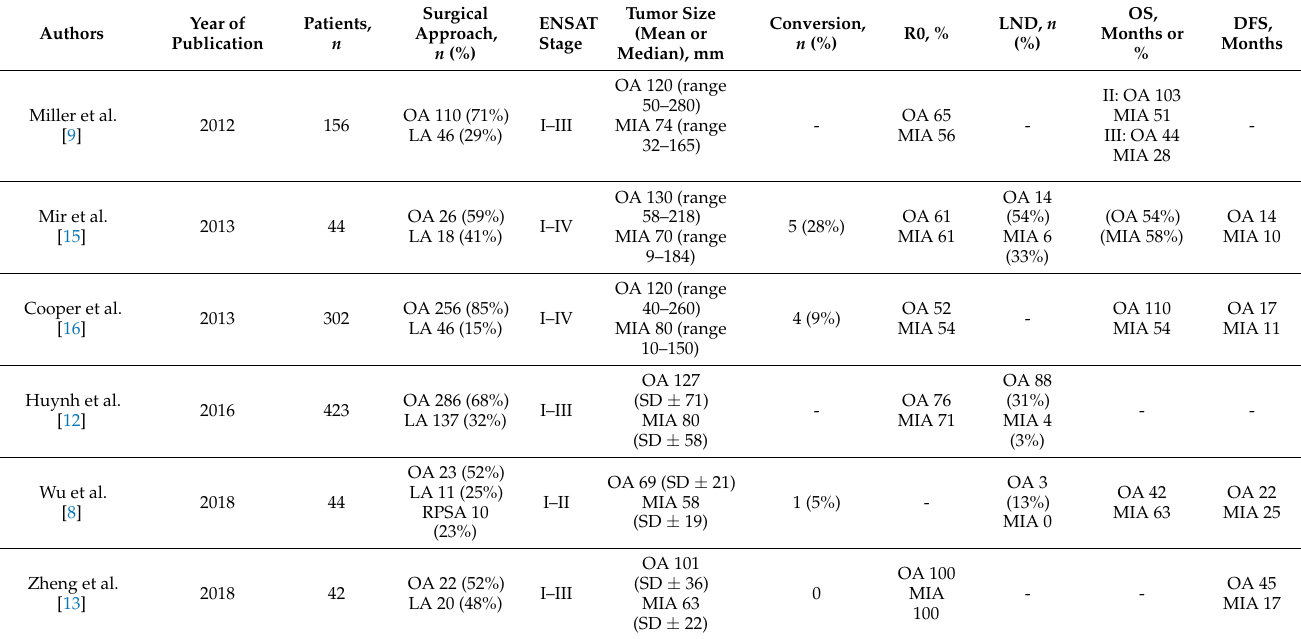
Table 1. Studies supporting open approach for the treatment of